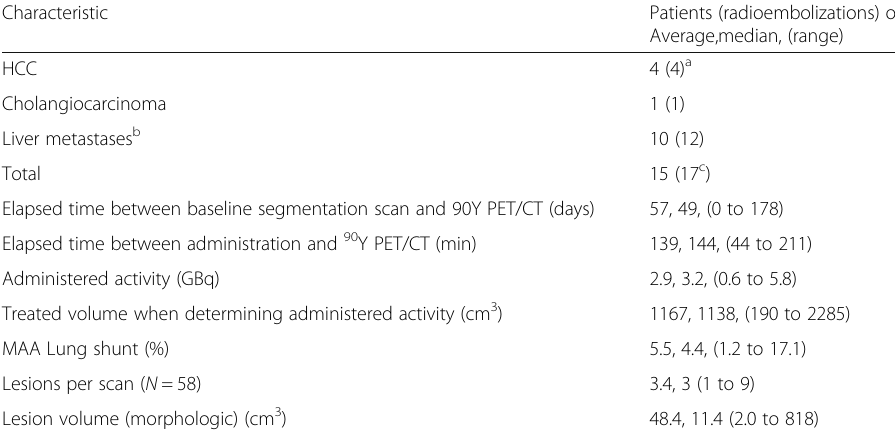
Table 1 Summary of analyzed patient and lesion characteristics